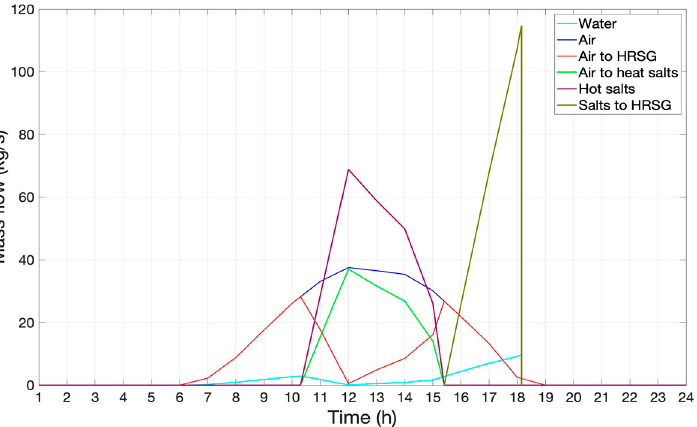
Figure 6. Instantaneous mass flow changes for the ISCC power plant with TES system (21st of June).